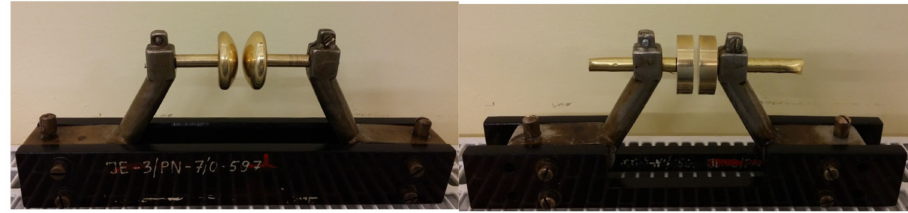
Figure 2. Electrode holder assemblies ( left —VDE, right —disc electrode).